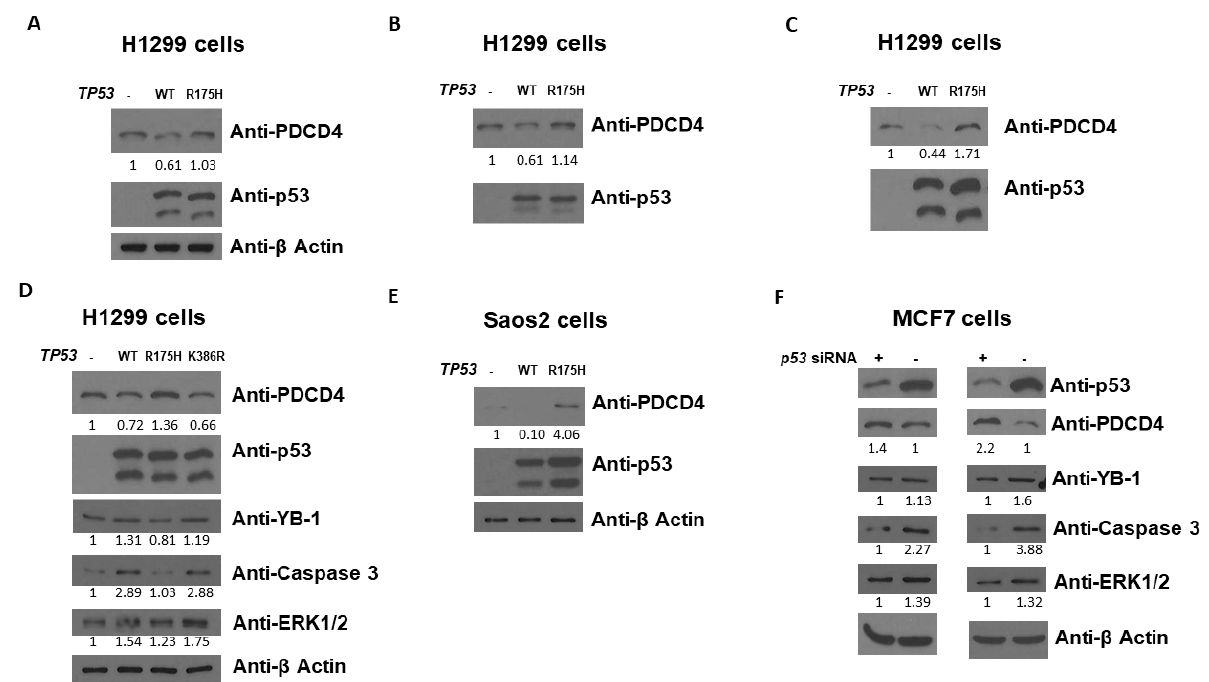
Figure 1. p53 decreases PDCD4 protein level. Western blot analysis of PDCD4 expression from H1299 ( A – D ) and Saos2 ( E ) cells transfected without or with WT or mutant p53 expression plasmids. ( F ) Western blot analysis of PDCD4 expression from MCF7 cells treated with p53 siRNA. The expression levels of p53 and PDCD4 were determined using anti-p53 and anti-PDCD4 immunoblot- ting, respectively. The expression levels of YB-1, Caspase 3, and ERK1/2 were also determined on panel ( D , F ). The β -Actin levels were determined for equal loading on panel ( A , D – F ). The original WB can be found in Supplementary Material.